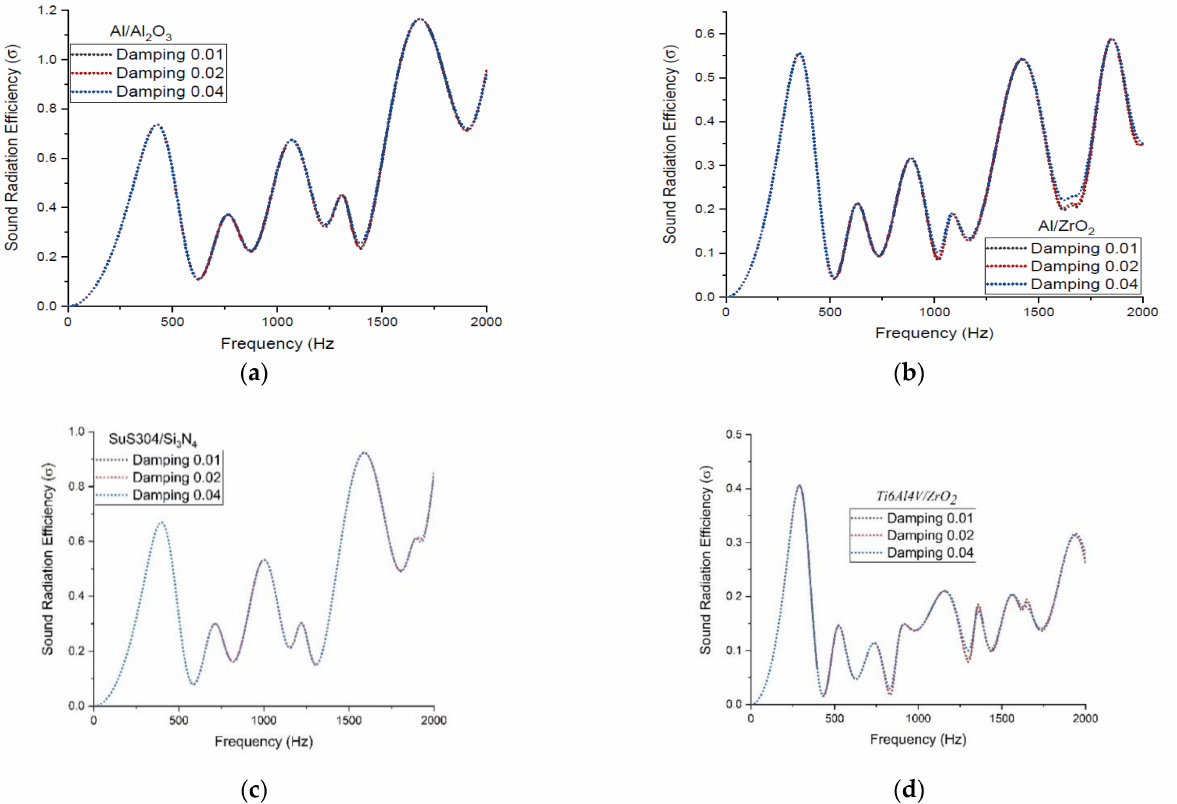
Figure 14. Radiation efficiency of ( a ) Al/Al 2 O 3 , ( b ) Al/ZrO 2 , ( c ) SuS304/Si 3 N 4 , and ( d ) Ti6Al4V/ZrO 2 P-FGM plates under different damping loss